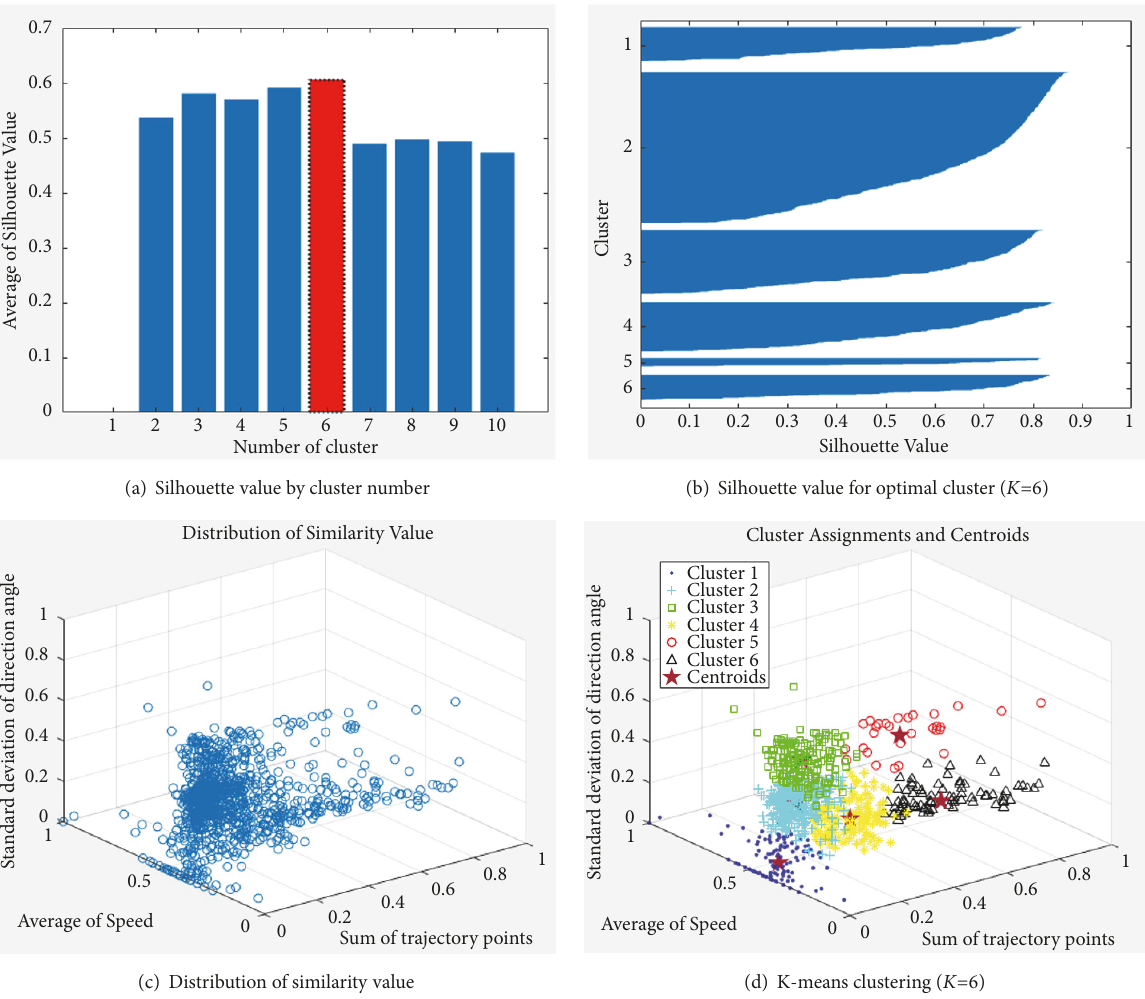
Figure 6: Results of the optimal cluster number and K-means clustering. (a) and (b) indicate optimal number of clusters using the silhouette method. (c) and (d) represent the clustering result with the optimal clustering number K=6 . Each point represents the feature vectors for a spatial 1 m × 1m cell in